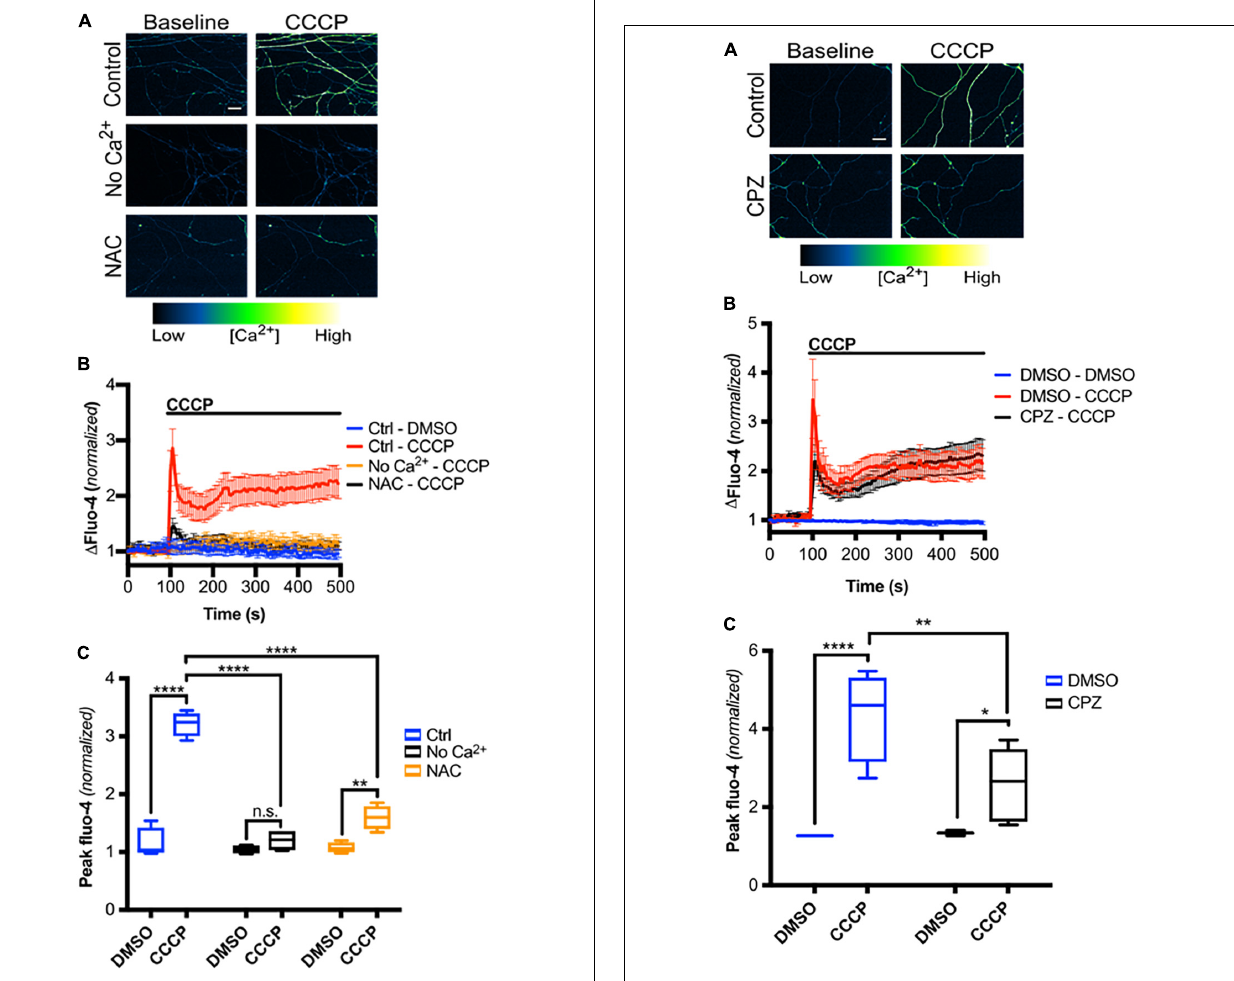
Frontiers in Molecular Neuroscience |